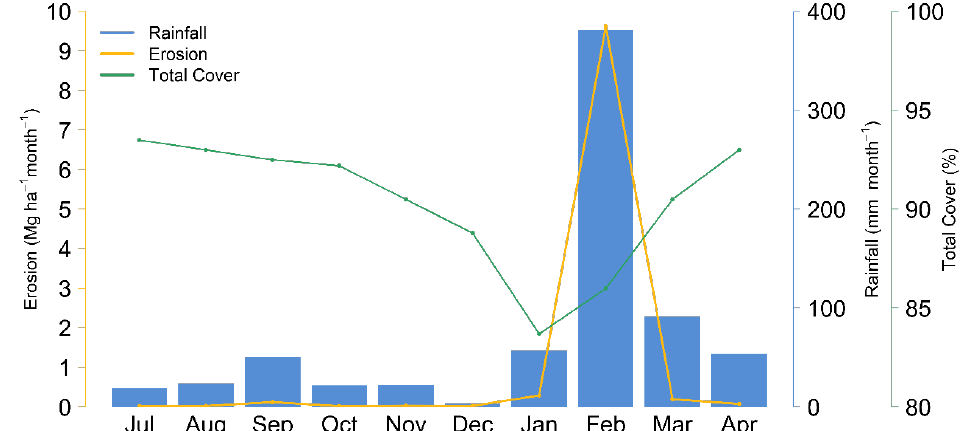
Figure 4. Relationships between erosion and fractional vegetation cover (total cover); and erosion and